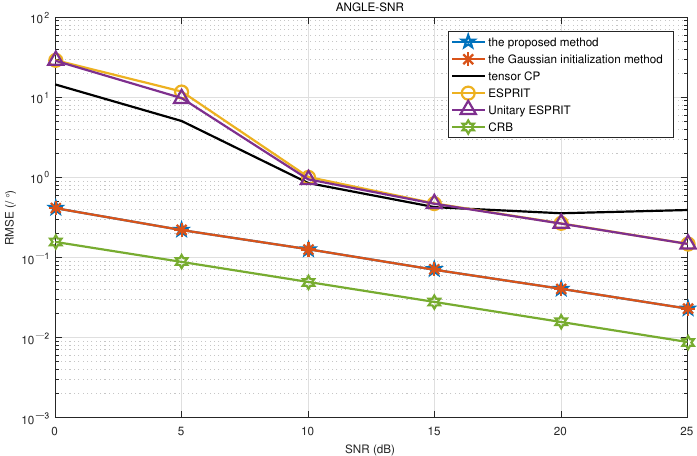
Figure 7. RMSE of angle estimation versus SNR with closed